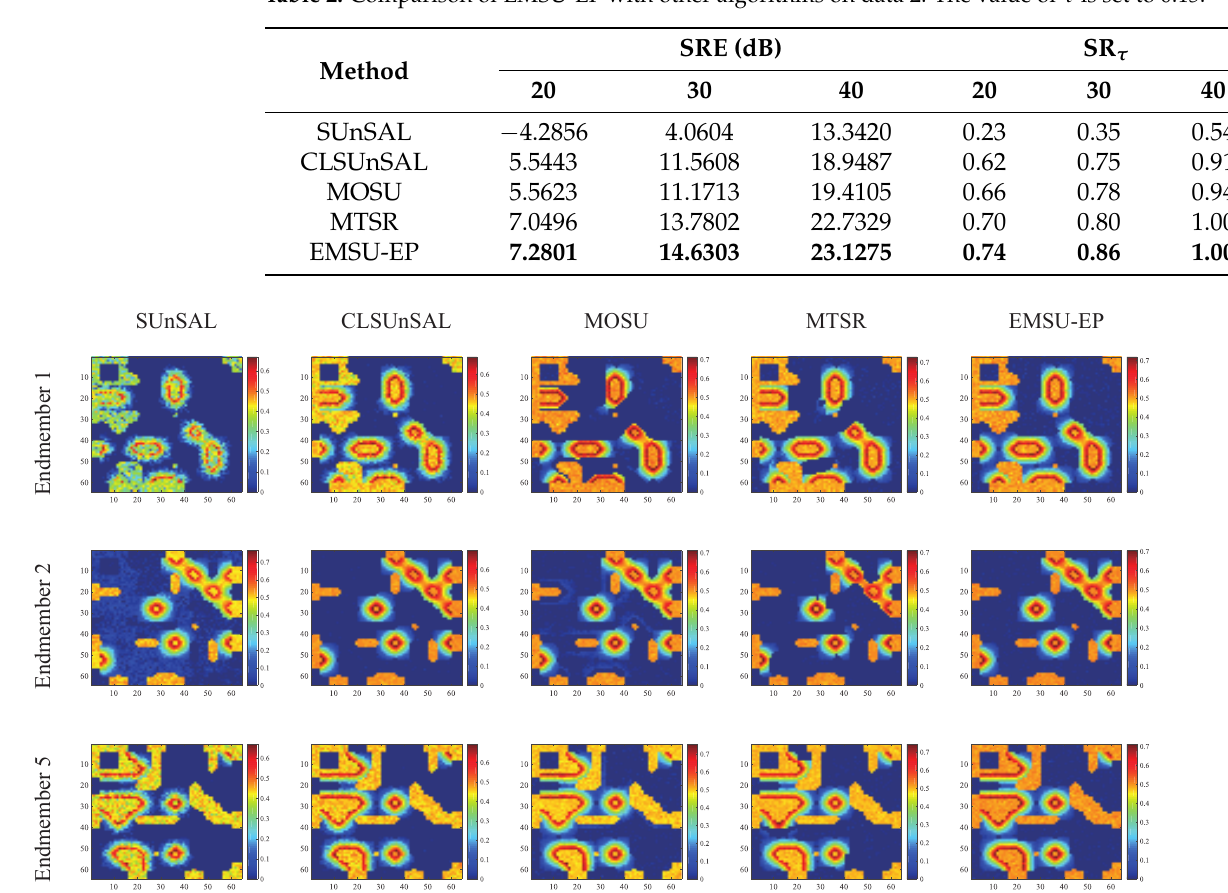
Table 2. Comparison of EMSU-EP with other algorithms on data 2. The value of τ is set to 0.15.